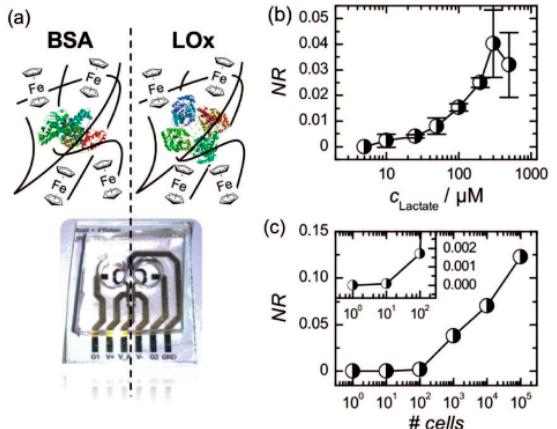
Figure 2. ( a ) Lactate oxidase and ferrocene cross-linked with chitosan and immobilized on the sensing organic electrochemical transistor (OECT) using epoxy terminated self-assembled monolayers. A second OECT is used as reference, where the same complex is used but where the specific enzyme is substituted by bovine serum albumin (BSA); ( b ) calibration curve for three different devices. The normalized response (NR) is NR = ∆ V out / ∆ V out,max . The gate voltage is kept constant at V GS = 200 mV; ( c ) titration curve for successive additions of media collected from cells cultured at different concentrations for 24 h. Reproduced from Braendlein et al. [7]. Copyright © 2017, John Wiley and